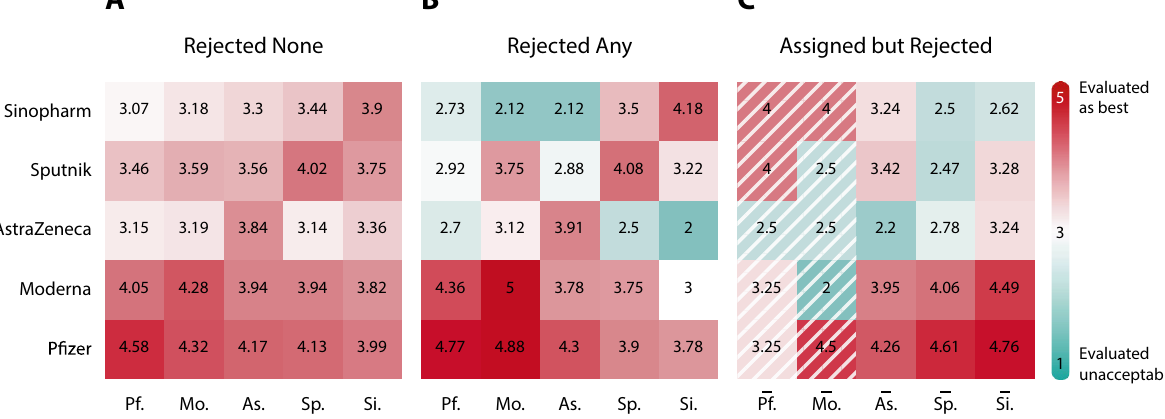
Figure 4. Average vaccine rating by assigned, re-selected and rejected vaccines show polarization of vaccine hesitancy. Individuals are grouped by columns of received vaccine in ( A ) and ( B ) and by columns of assigned vaccine in ( C ) (marked by overline). Rows correspond to average rating of a certain vaccine. ( A ) Ratings of those patients who accepted their first vaccine offer suggest that Pfizer and Moderna were the best assessed vaccines. ( B ) Ratings of those patients who rejected at least one assigned vaccine reveal that re-selection of vaccines is paired with better assessment of the received vaccine. ( C ) Ratings of those patients who rejected at least one assigned vaccine illustrate polarization of hesitancy by vaccine types. The average rating in the first two shaded columns are calculated from few observations